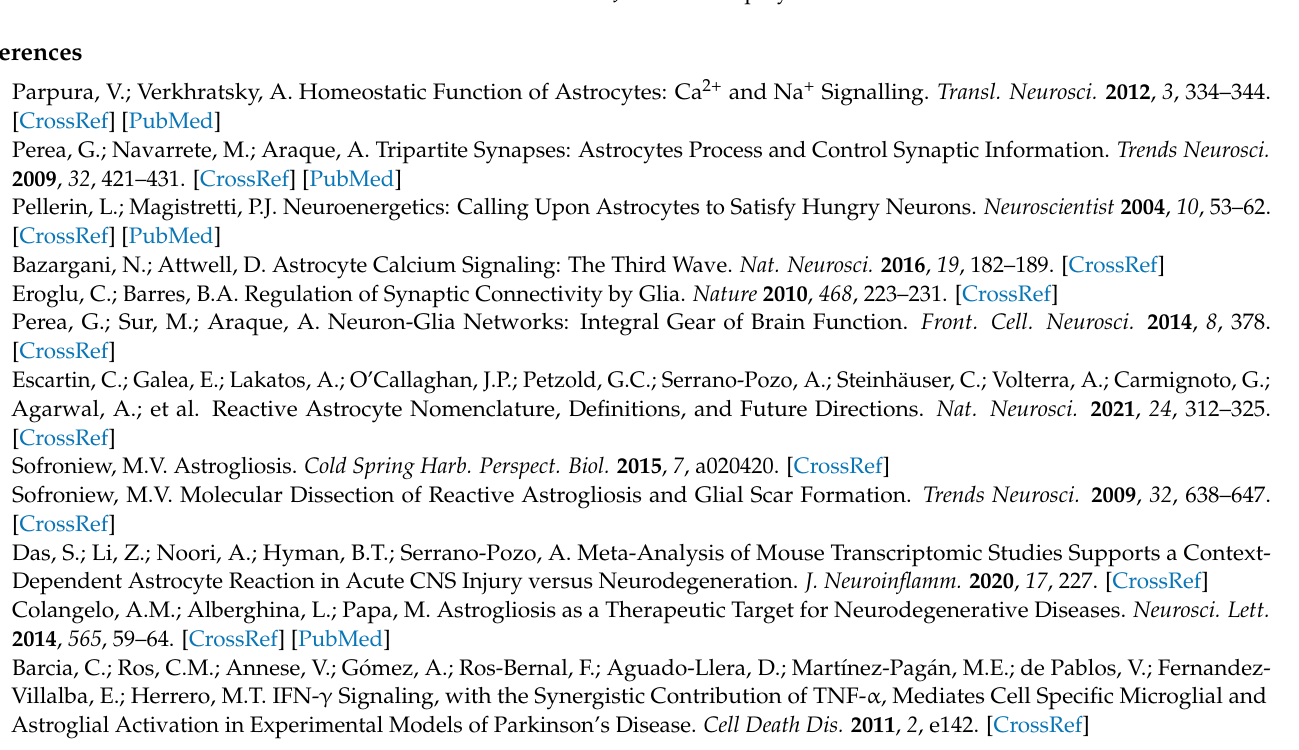
induction; Figure S3: Cytokine-induced reactive astrogliosis does not affect astrocyte proliferation; Figure S4: Supplementation with high dose FC (0.2 × ) prevents the induction of reactive astrogliosis by TNF- α and IFN- γ ; Figure S5: FC prevents the cytokine-induced increase in GFAP and Vimentin protein levels; Figure S6: The effect of cytokine treatment and FC supplementation on astrocyte viability, proliferation, Aldh1l1 protein levels and NF- κ B nuclear